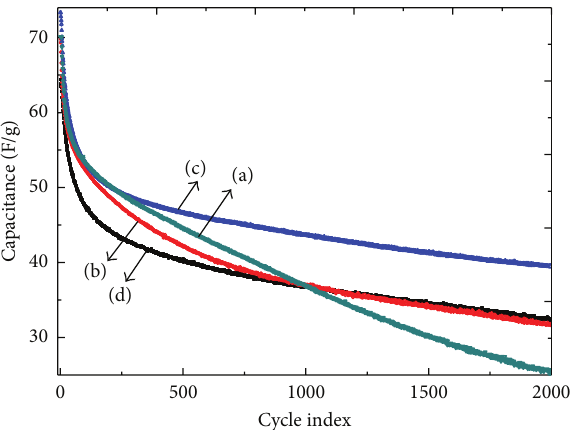
Figure 6: Life cycle plot. (a) 𝑟 = 80 :50. (b) 𝑟 = 80 :80. (c) 𝑟 = 80 :120. (d) 𝑟 = 80